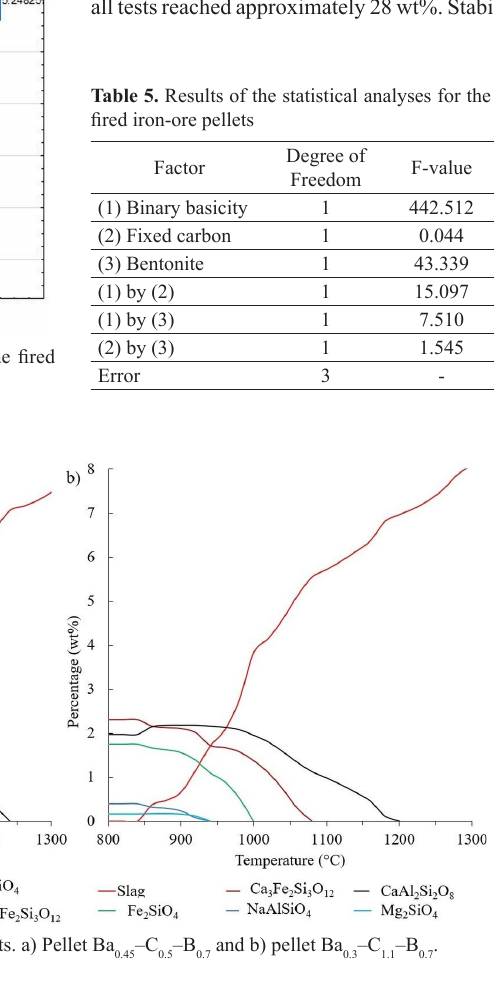
Figure 7. Thermodynamic simulation of the iron-ore pellets. a) Pellet Ba